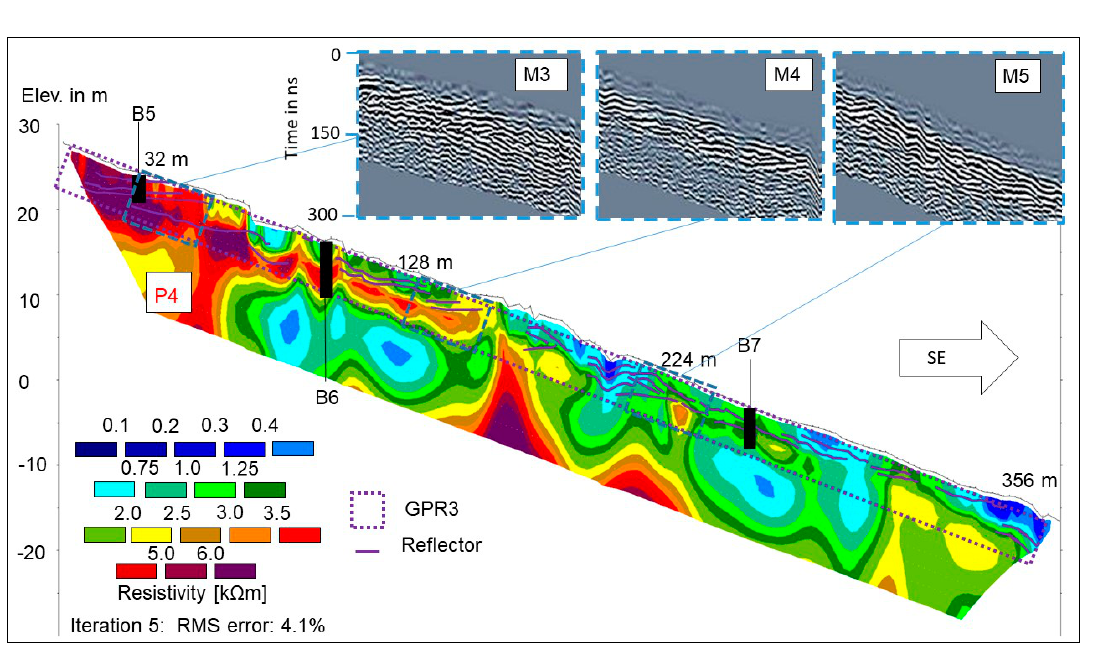
Figure 10. Geophysical surveys of "Gebranntes Bruch".